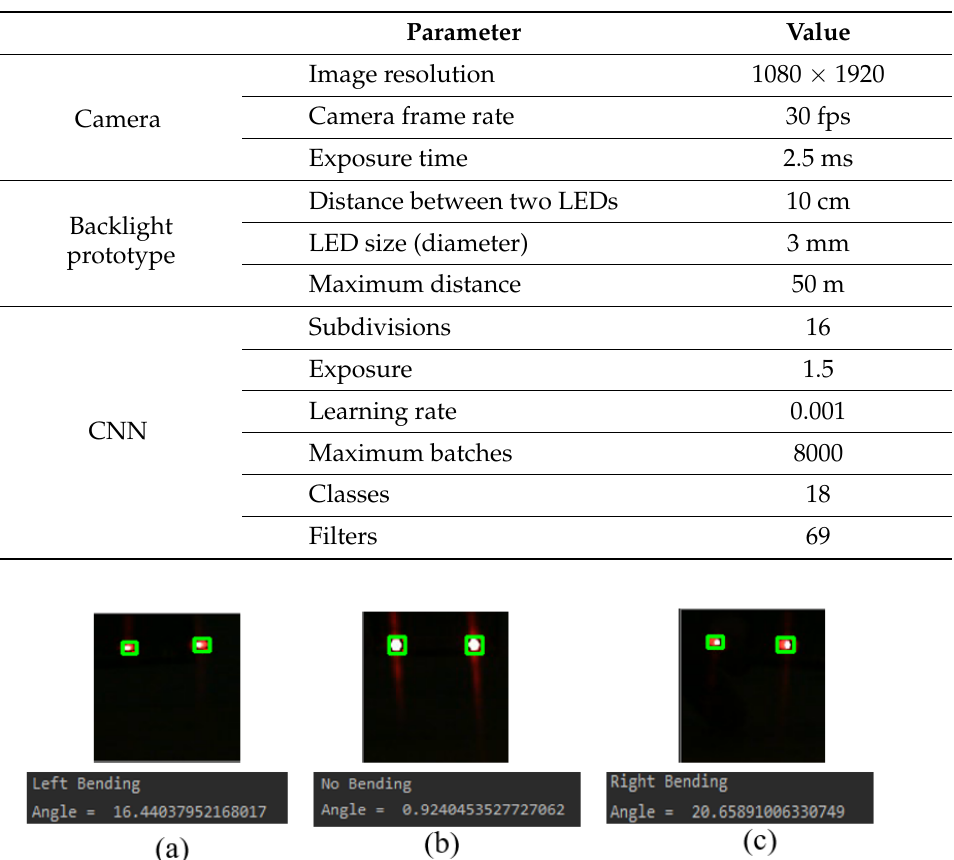
Table 1. Implementation parameters.